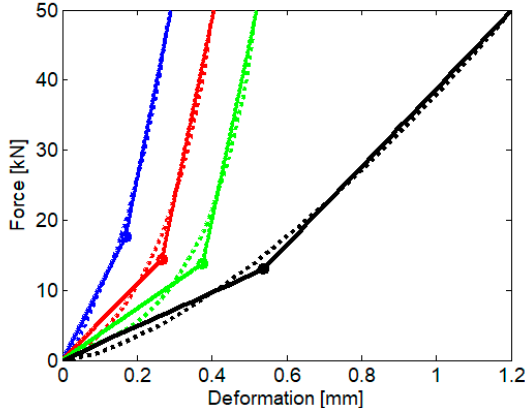
Figure 6. Bilinear function: ( a ) for rail pad; ( b ) for ballast.